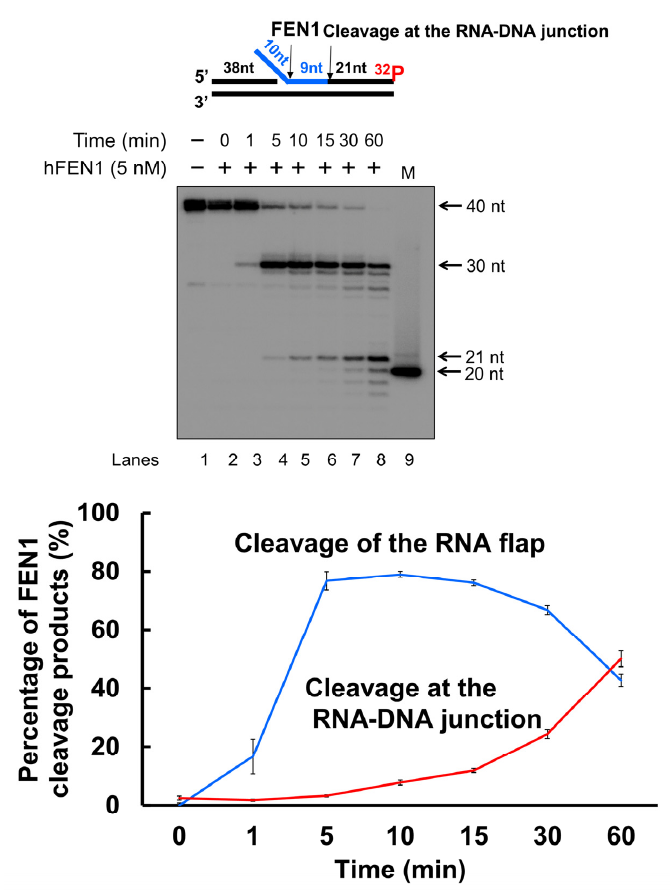
Figure 3. FEN1 cleavage of RNA and DNA in an RNA/DNA hybrid at different time intervals. To compare the efficiency of FEN1 cleavage on the RNA flap and RNA-DNA junction, FEN1 (5 nM) cleavage on the RNA (blue) and DNA strand of the substrate (25 nM) containing a 10 nt RNA flap was measured at different time intervals (0–60 min). The results were shown in the gel (top panel). Lane 1 represents substrate only. Lane 2–8 represents the reaction mixture with FEN1 cleavage products generated from 0–60 min. Lane 9 is a 20 nt size marker. Quantification of the FEN1 cleavage products is shown in the bottom panel. The line in blue indicates FEN1 cleavage on the RNA flap. The line in red indicates FEN1 cleavage at the RNA-DNA junction. The substrate was 32 P-labeled at the 3 (cid:48) -end of the downstream strand of the substrate. Substrate and products were separated in a 15% urea-denaturing polyacrylamide gel and detected by phosphorimagery. The experiments were performed in